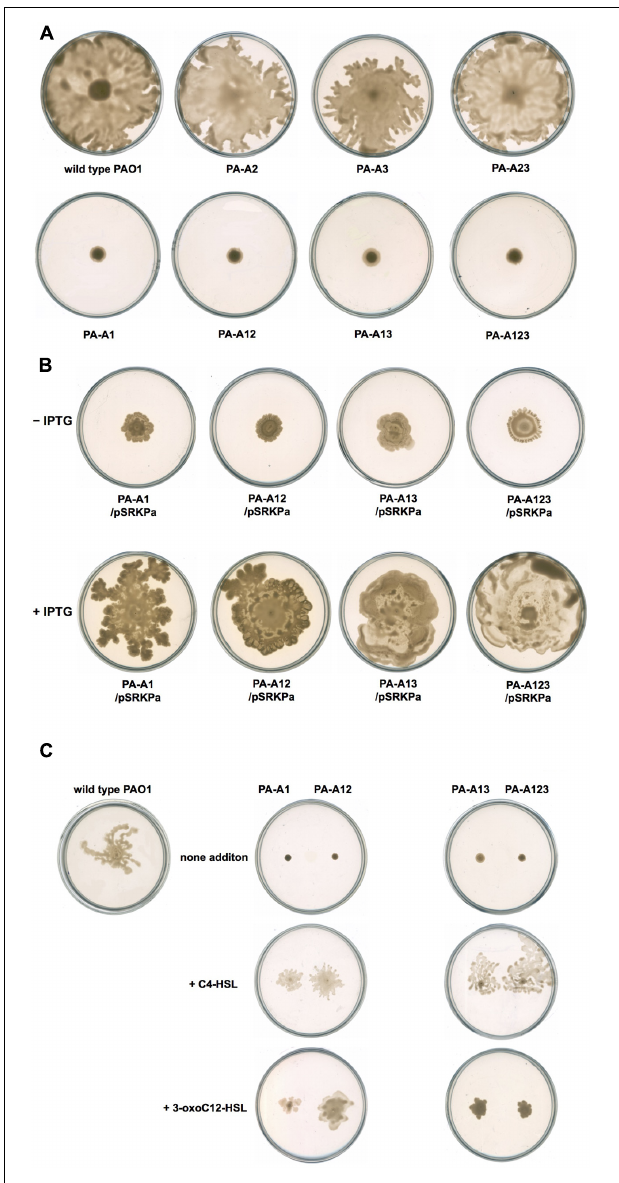
FIGURE 7 | Swarming motility of P. aeruginosa strains. (A) Swarming motility patterns of P. aeruginosa acpPs mutant strains. (B) Swarming motility patterns of P. aeruginosa acpP1 mutant strains carried plasmid pSRK-Pa. (C) Effect of exogenous AHLs on swarming motility of P. aeruginosa acpP1 mutant strains. PAO1, P. aeruginosa wild type strain; PA-A1, P. aeruginosa acp1 ::Ec acpP single mutant strain; PA-A2, P. aeruginosa acpP2 ::Gm r single mutant strain; PA-A3, P. aeruginosa acpP3 ::Gm r single mutant strain; PA-A12, P. aeruginosa acp1 ::Ec acpP acp2 ::Gm r double mutant strain; PA-A13, P. aeruginosa acp1 ::Ec acpP acp3 ::Gm r double mutant strain; PA-A23, P. aeruginosa acp2 ::Tc r acp3 ::Gm r double mutant strain; PA-A123, P. aeruginosa acp1:: Ec acpP acp2:: Tc r acp3:: Gm r triple mutant